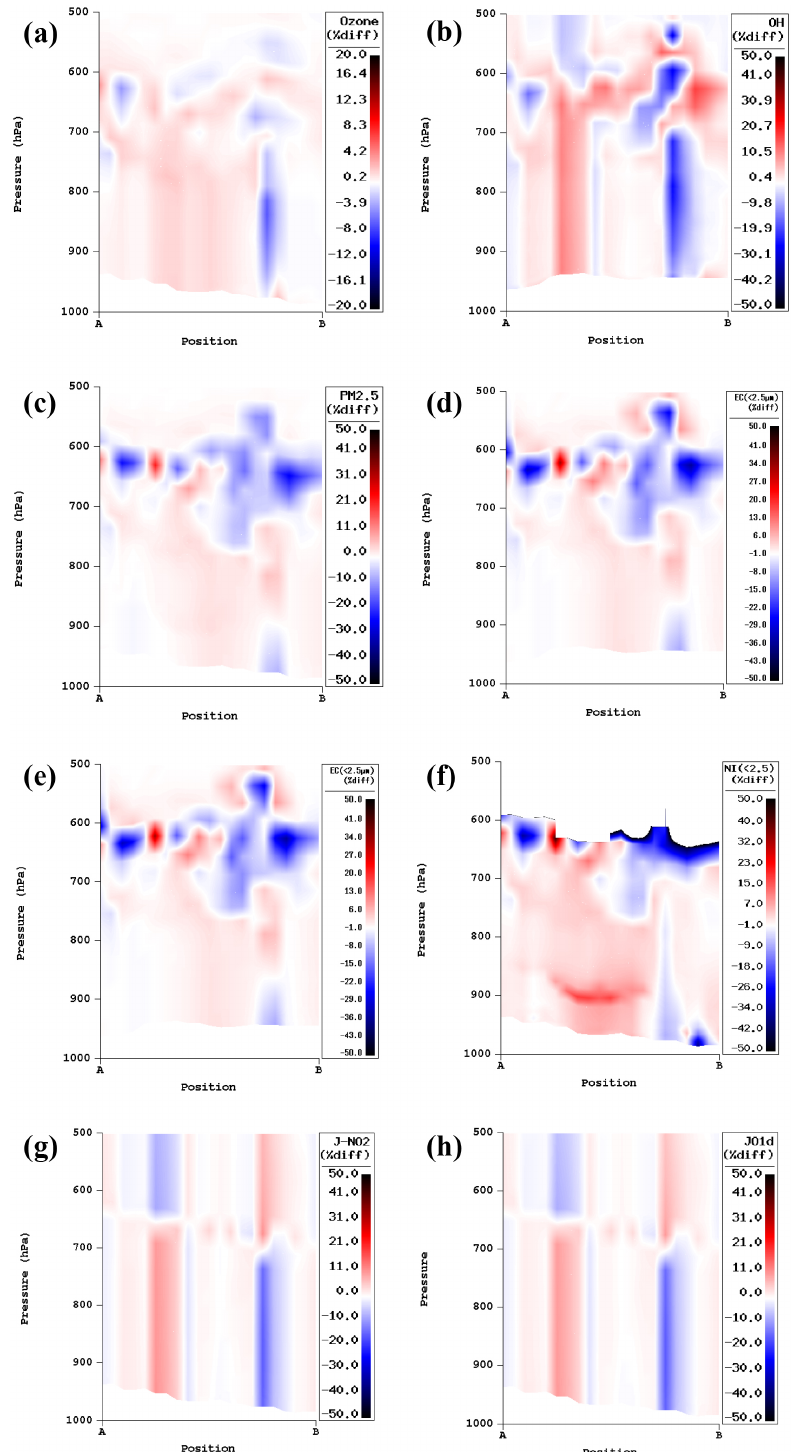
Figure 16. Cross sections of percentage difference in gas and aerosol concentrations and photolysis rates with and without AOD calculations (with aerosol feedbacks) over the line shown in Fig. 14c, Lac La Loche forest fire on 25 June 2018 at 23:00UTC: (a) ozone (ppb), (b) hydroxyl radical (µgkg − 1 ), (c) PM 2 . 5 (µgm − 3 ), (d) EC ( < 2 . 5µm, µgkg − 1 ), (e) nitrate ( < 2 . 5µm, µgm − 3 ), (f) SOA ( < 2 . 5µm, µgkg − 1 ), (g) J (NO 2 ) (s − 1 ), (h) J (O 1 D) (s − 1